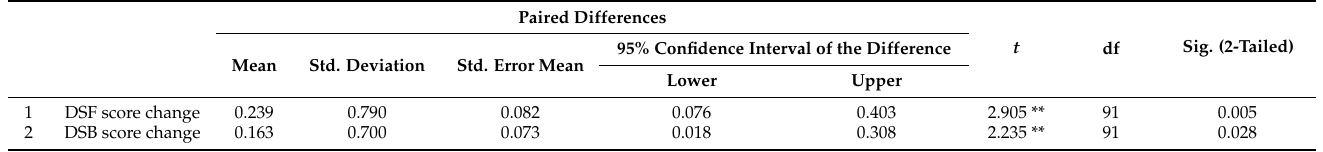
Table 4. Paired sample t -test of older adults’ attention test results in winter park.